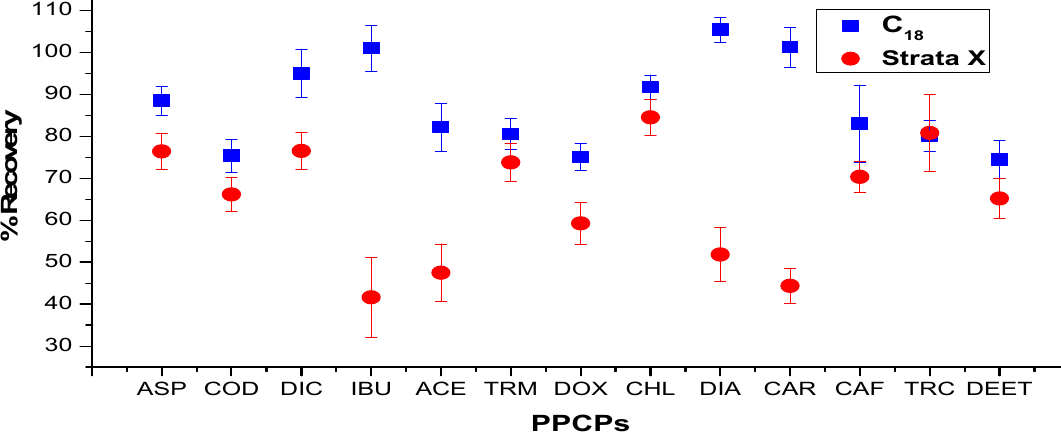
Figure 1. Recovery studied of the two selected cartridges in the 13 pharmaceuticals and personal care product PPCPs.